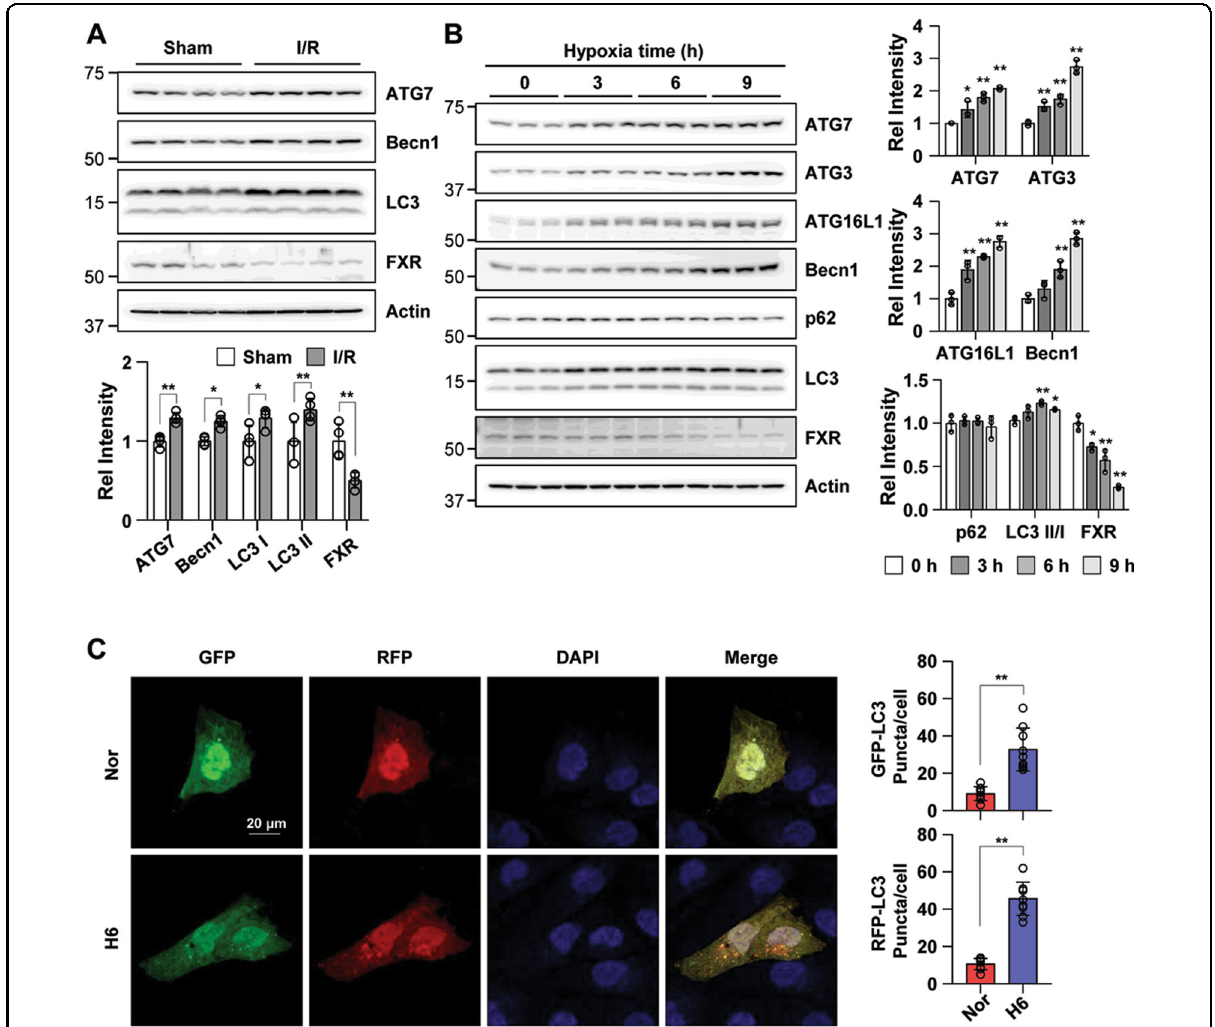
Fig. 1 I/R injury and hypoxia increase renal autophagy and decrease FXR expression in mice and HK2 cells. A At 48 h after I/R, the mice were euthanized, and the kidneys were collected ( n = 4). Protein levels of ATG7, Becn1, LC3, and FXR were detected by immunoblotting. The relative protein levels are shown. The values for the Sham group were set to 1. B HK2 cells were exposed to hypoxia for the indicated times, and the levels of autophagy-related proteins and FXR were detected by immunoblotting. The relative levels are shown ( n = 3). The level of each protein, including actin, in the 0 h hypoxia sample was set to 1. C HK2 cells were transfected with the ptf-LC3 expression plasmid, after which the cells were subjected to hypoxic conditions for 6 h. Fluorescence was imaged by confocal microscopy. The average number of LC3 II puncta per cell is shown on the right ( n = 8 – 9). Scale bar, 20 μ m. All values are presented as the mean ± SD. Statistical signi fi cance was measured using one-way ANOVA with